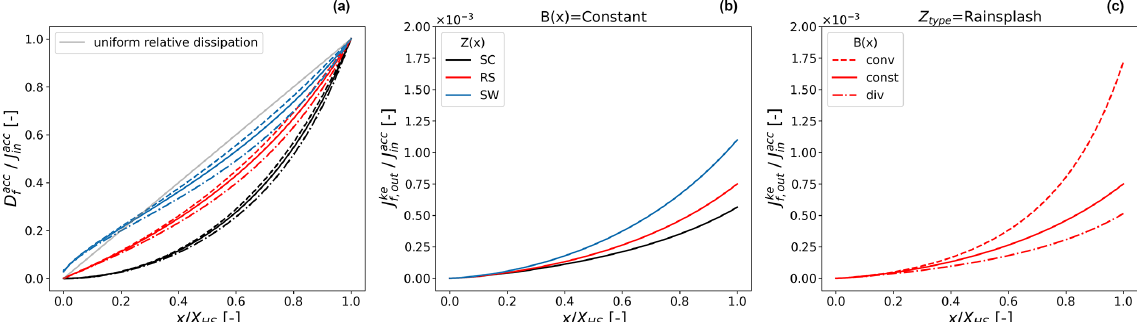
Figure 5. Spatial distribution of the ratio of (a) accumulated dissipation and accumulated energy influx, (b) kinetic energy outflux and accumulated energy influx for constant hillslope width but varying hillslope forms and (c) kinetic energy outflux and accumulated energy influx for hillslope form related to rainsplash but varying hillslope width